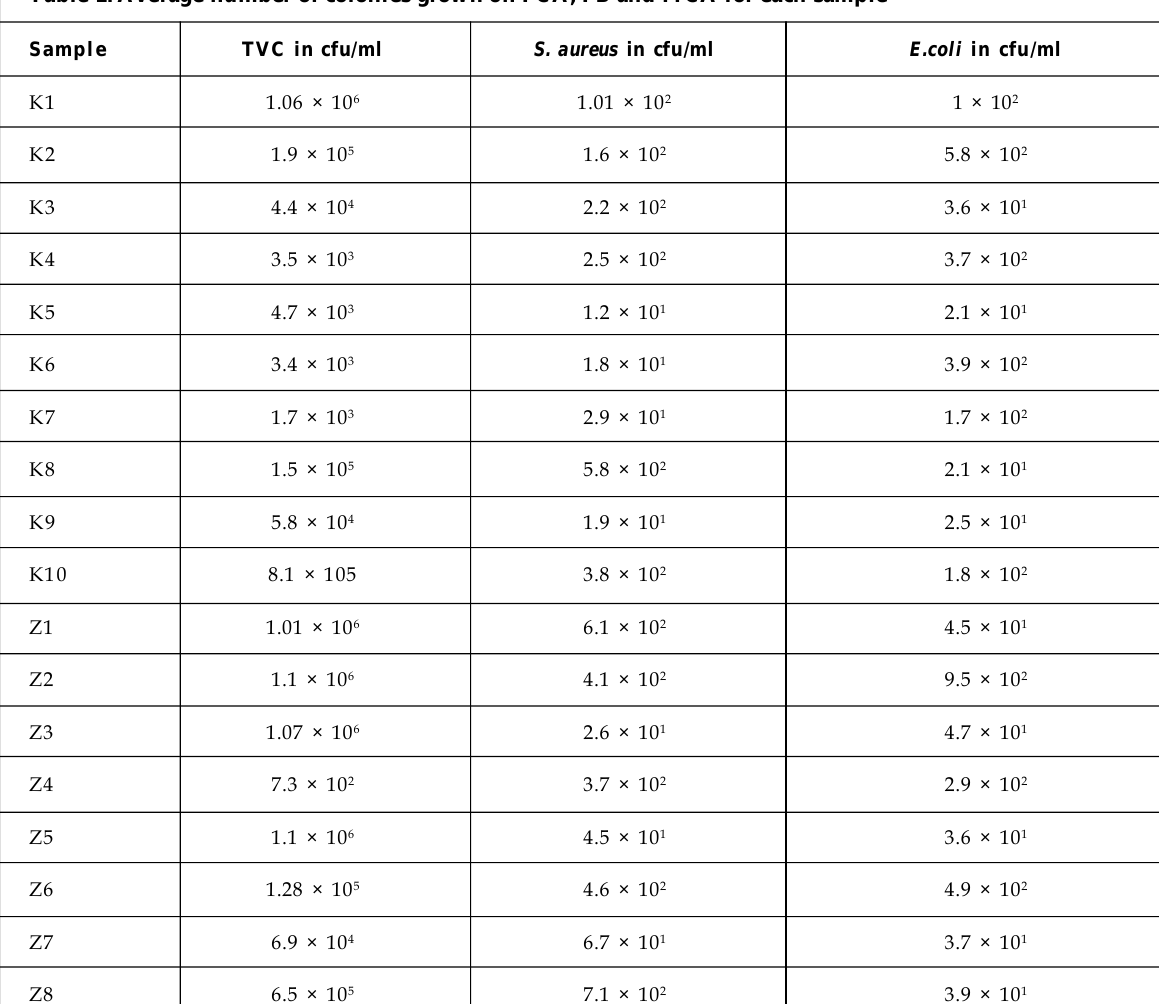
Table 1: Average number of colonies grown on PCA, PB and MCA for each sample